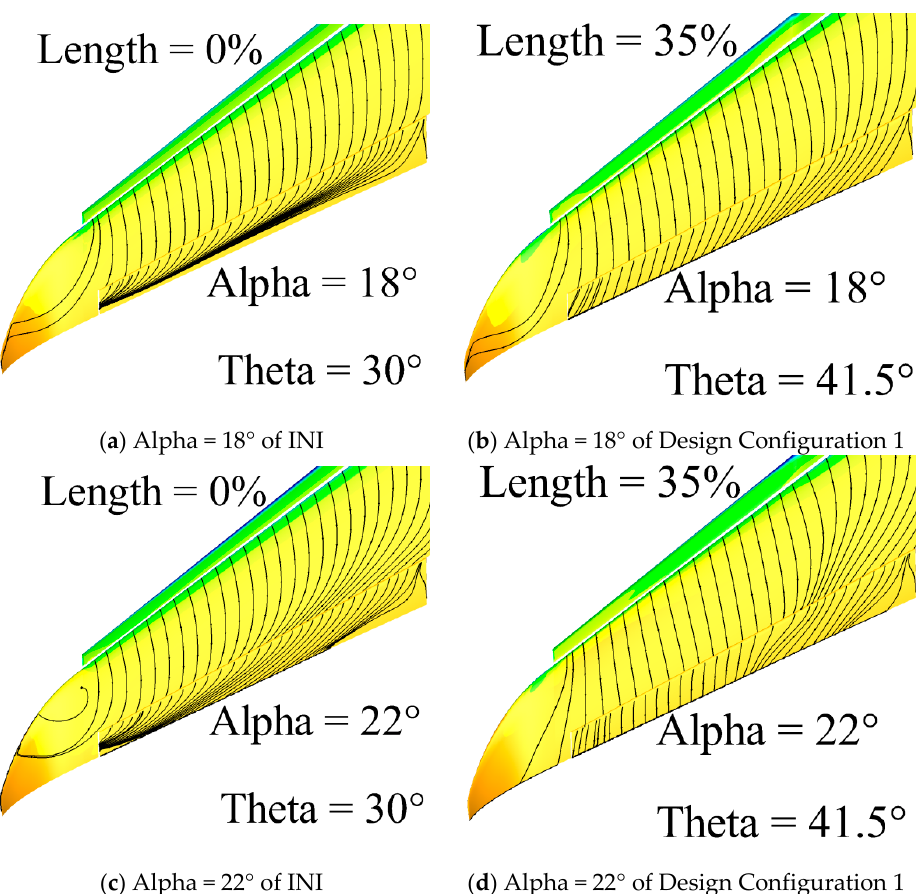
Figure 21. Upper surface limiting streamlines of INI and Design Configuration 1.